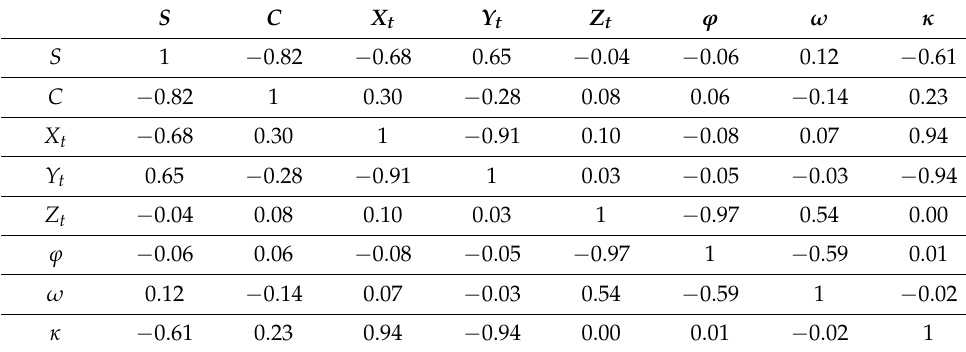
Table 15. The matrix of correlation coefficients of the unknowns for dataset DATA1.